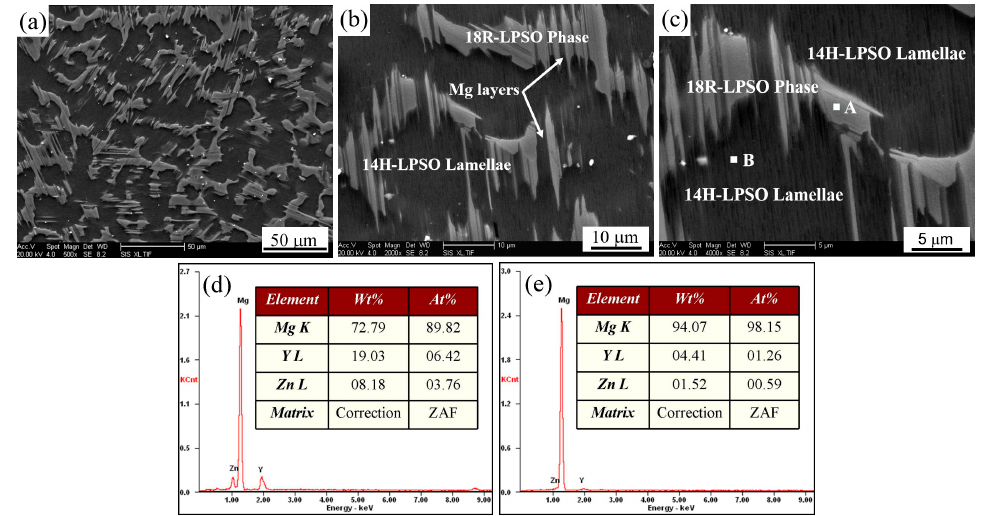
Figure 2. ( a – c ) microstructures of the as-cast Mg 95.5 Y 3 Zn 1.5 alloy; ( d ) energy dispersive spectrometer (EDS) results of the point A in (c); ( e ) EDS results of the point B in ( c ).